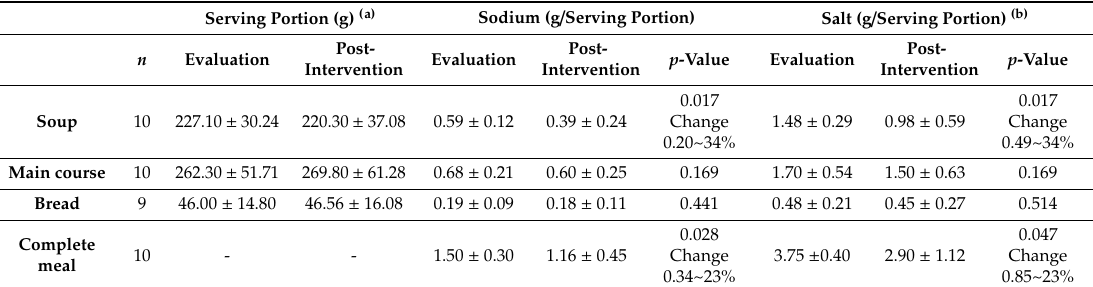
Table 1. Sodium and salt content of school meals components (soup, main course, and bread) and of the complete meal (all components) analyzed at the evaluation and the post-intervention phases of the eat Mediterranean program.